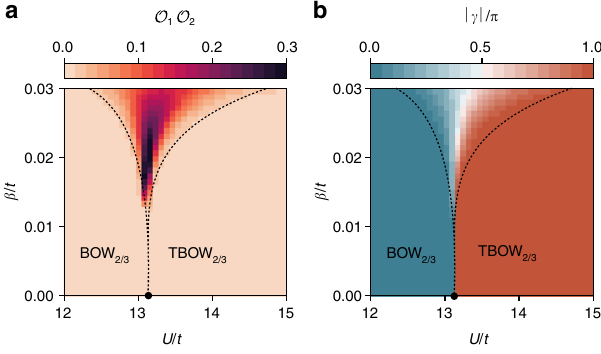
Fig. 4 Phase diagram: a in the background, we represent the product of observables O 1 O 2 , which has a nonzero value only in the intermediate phase, where bond-inversion symmetry is broken. The black dot marks the fi rst-order critical point separating the BOW 2/3 and TBOW 2/3 phases at β = 0. The dotted lines qualitatively denote the critical lines for β > 0. For large values of this parameter, we fi nd an intermediate phase where the bond-inversion symmetry is broken. This phase is separated from the BOW 2/3 and TBOW 2/3 phases by continuous transitions. This situation might extend up to β = 0, although fi rst-order transitions are also possible for small but not-zero values of β . b We also present the total Berry